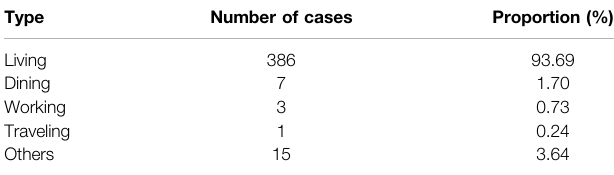
TABLE 1 | Numbers of different types of close contact events.